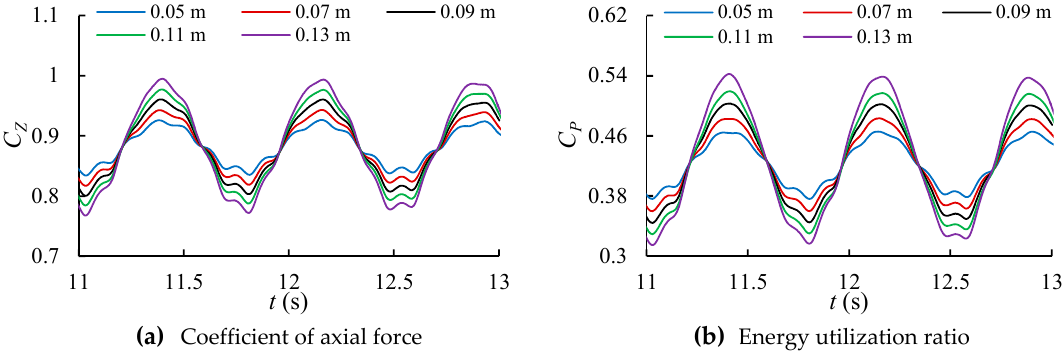
Figure 8. Time history curves of different wave heights.